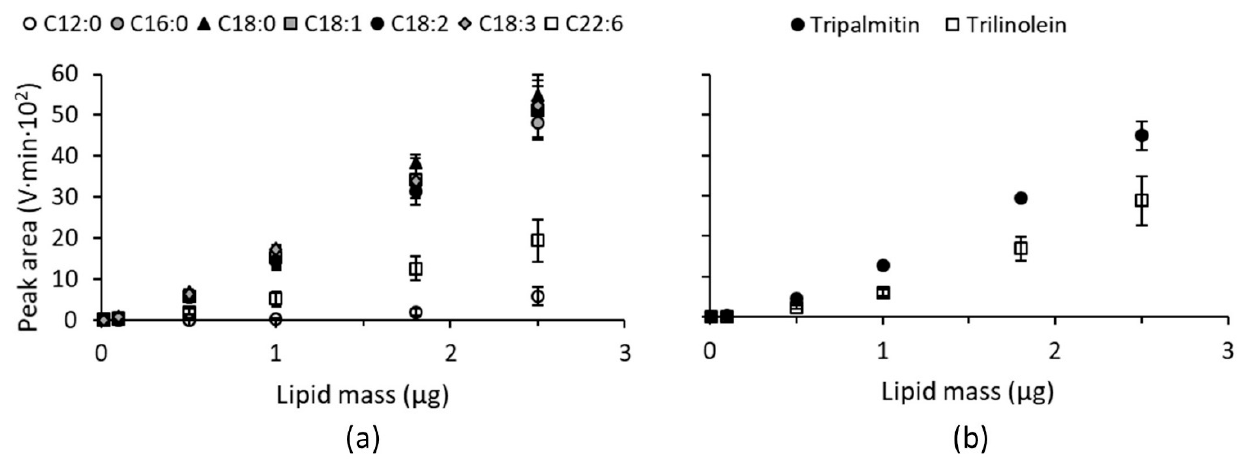
Figure 2. Evaporative light scattering detection responses expressed as peak areas (V·min·10²) as a function of the analyzed lipid mass (µg) for different ( a ) free fatty acids and ( b ) triacylglycerols. Average values with corresponding standard deviations of triplicate measurements are shown. C12:0, lauric acid; C16:0, palmitic acid; C18:0, stearic acid; C18:1, oleic acid; C18:2, linoleic acid; C18:3, linolenic acid; C22:6, cervonic acid.